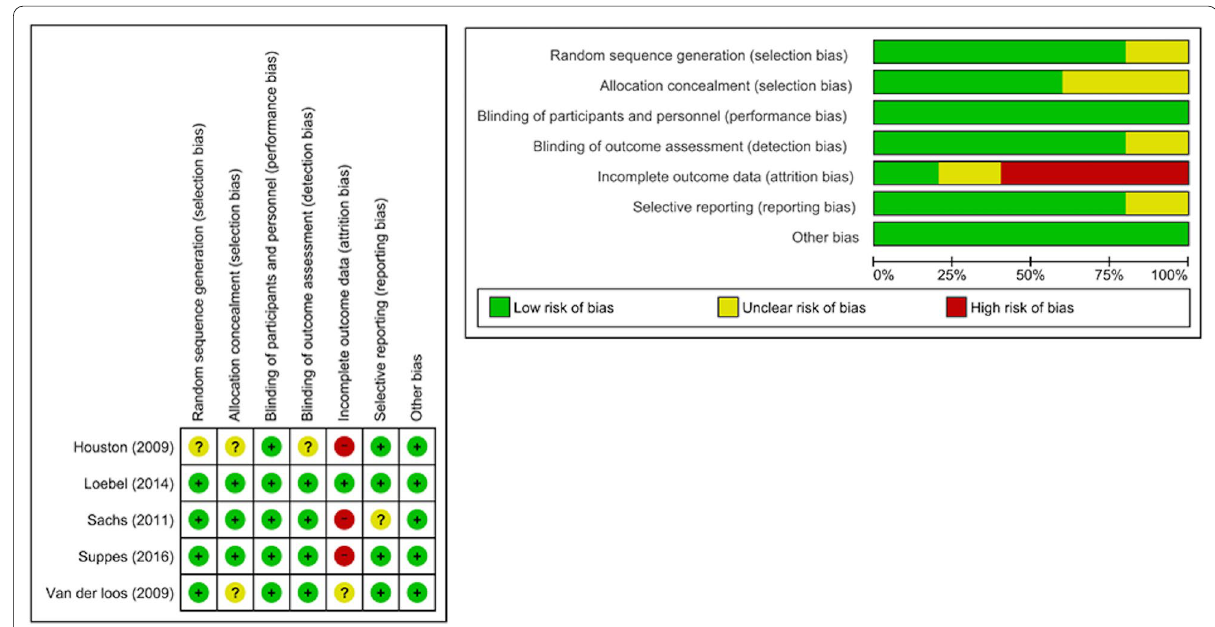
Fig. 2 Risk of bias assessment. Green indicates a low risk of bias, yellow indicates an unclear risk of bias, and red indicates a high risk of